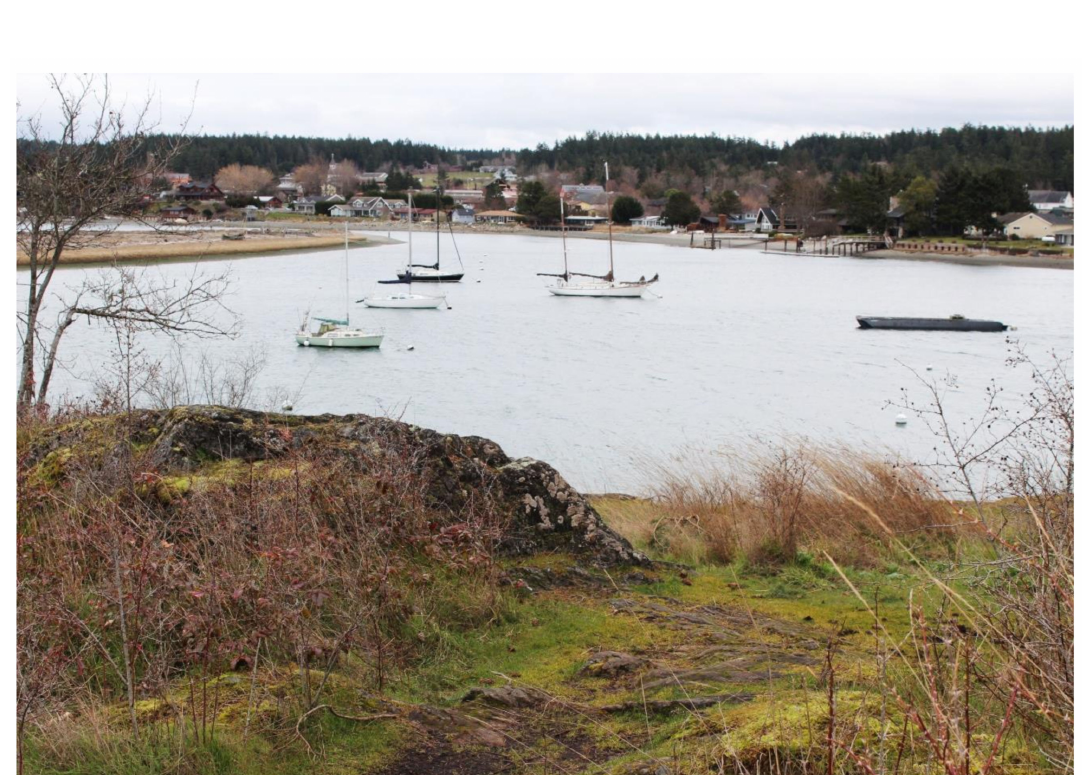
Figure 2. Researcher photo of Lopez Island,